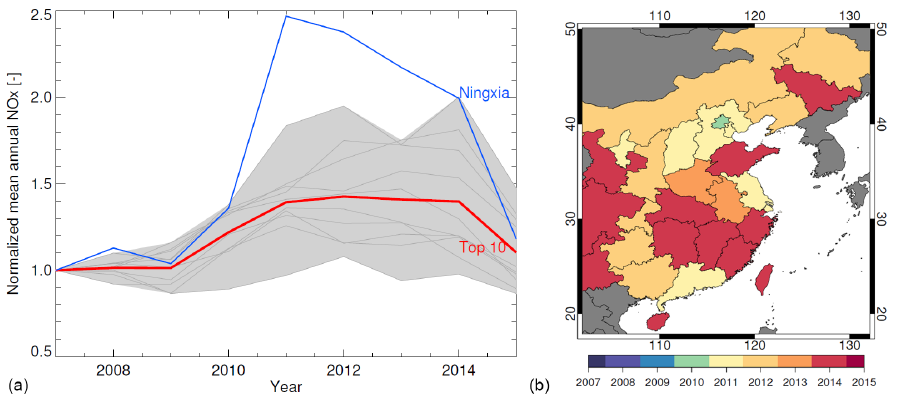
Figure 5. (a) The annual total NO x emission estimates for the last 9 years for the top 10 highest NO x -emitting provinces in East China. Emis- sions are derived with DECSO V4 using OMI observations. The thin grey lines show the individual time series of those provinces. (b) Peak year of the NO x emissions per province.